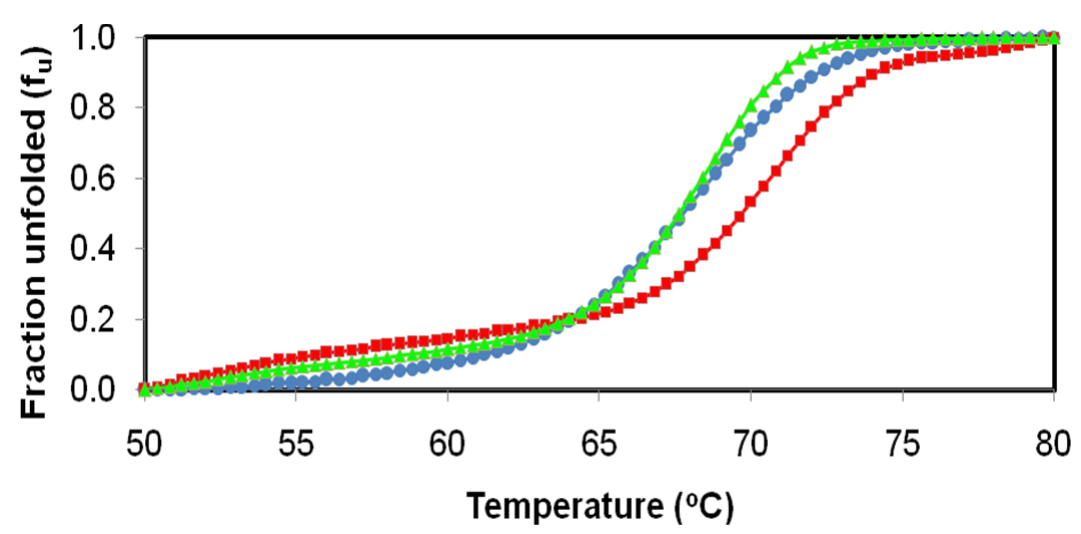
of T1 lipase (blue) was at m